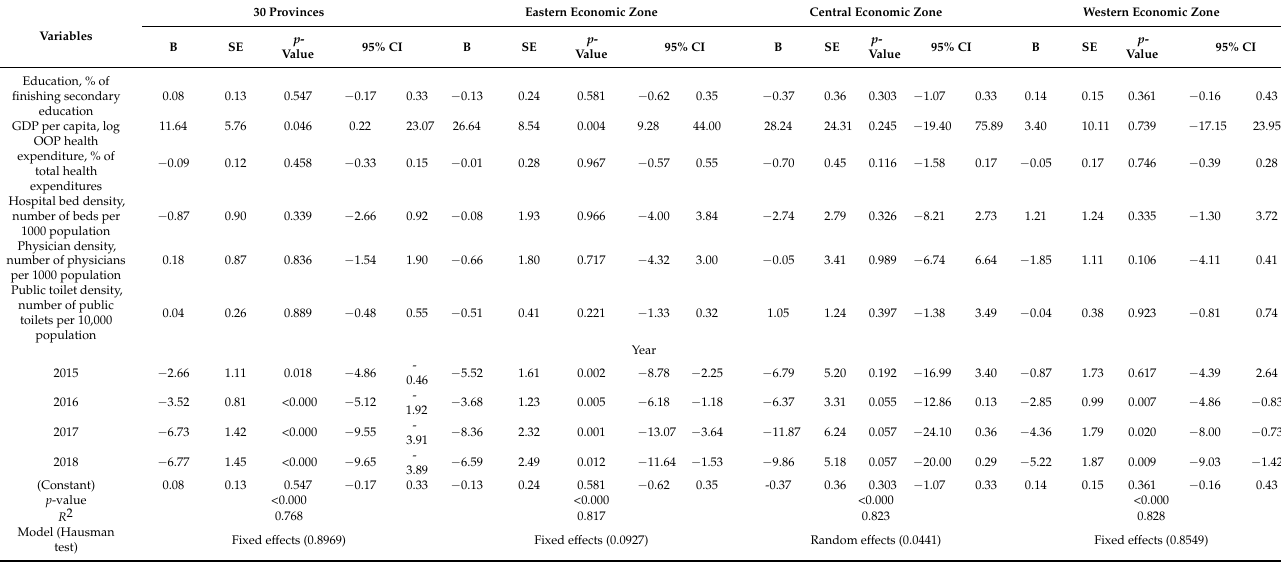
Table 2. Effect of variables on the aggregate resistance (including MRSA, 3GCREC, and 3GCRKP) among 30 provinces, as well as in the eastern economic zone, central economic zone, and western economic zone in mainland China (excluding the Tibet autonomous region).